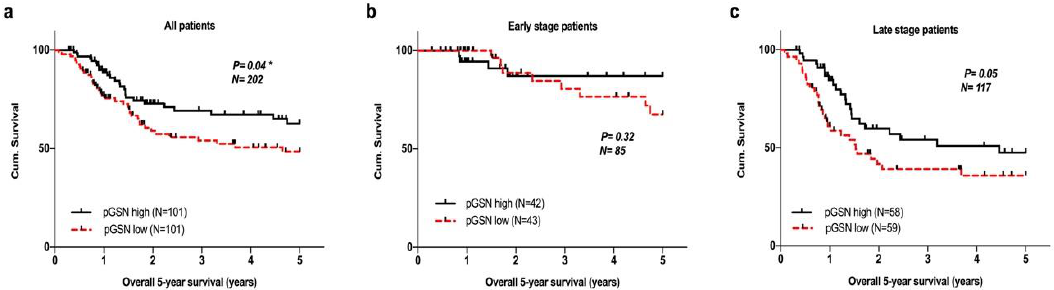
Figure 4. Influence of circulating pGSN levels on 5-year survival of patients with HNC. ( a ) Circulating pGSN in the whole HNC population ( n = 202) exhibited significant predictive value for 5-year survival, as evaluated using Kaplan–Meier analysis ( p = 0.04). Higher circulating pGSN levels predicted superior clinical outcomes than did lower pGSN levels. ( b ) Circulating pGSN levels had no significant effect on the overall survival (OS) of early-stage patients with HNC. ( c ) High circulating pGSN expression tends to confer longer OS in late-stage subgroup than those with lower pGSN levels ( p = 0.05). The p values were calculated using the log-rank test.